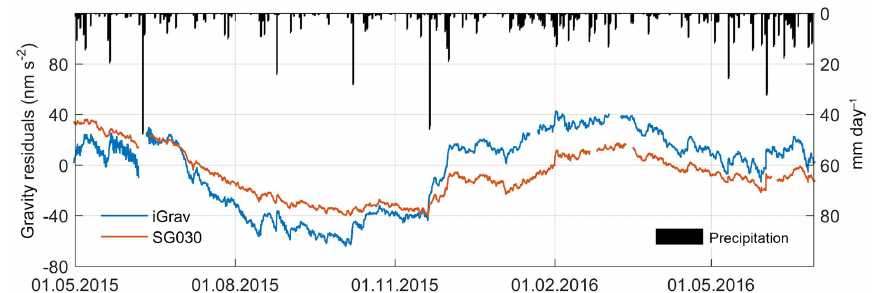
Figure 3. Time series of gravity residuals of iGrav006 in the field enclosure and of SG030 in the observatory building, and daily precipitation rates (from top and right axis) at the Wettzell